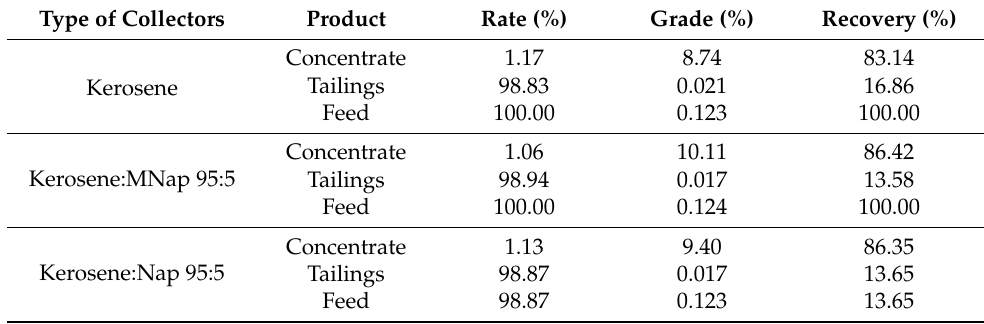
Figure 9. Recovery of molybdenite flotation concentrates with and without auxiliary collector. Table 6. Results of closed-circuit flow